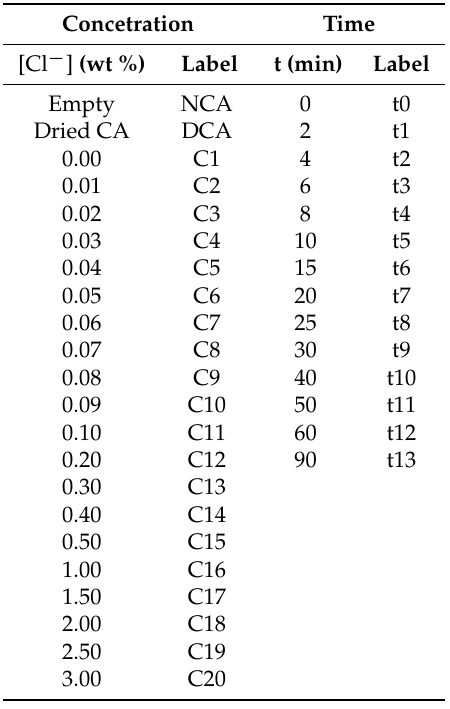
Table 5. Experimental design for performance